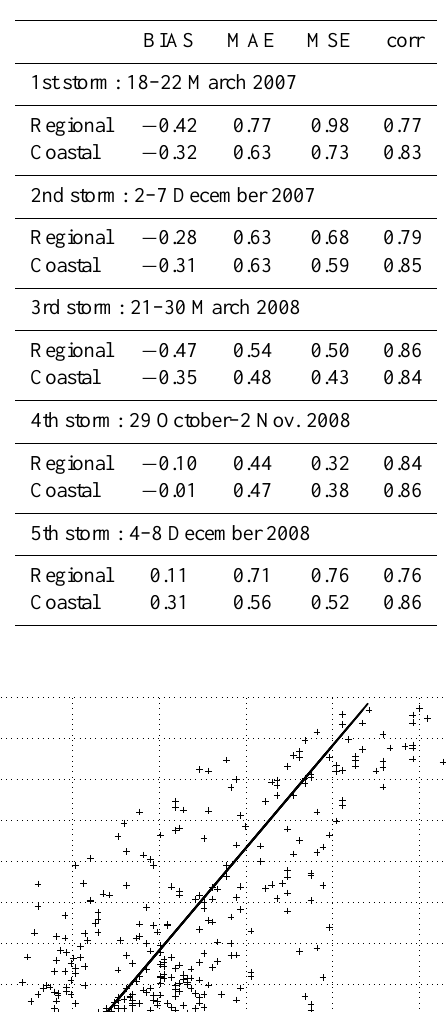
Table 1. Statistical results for the Carrara storm events